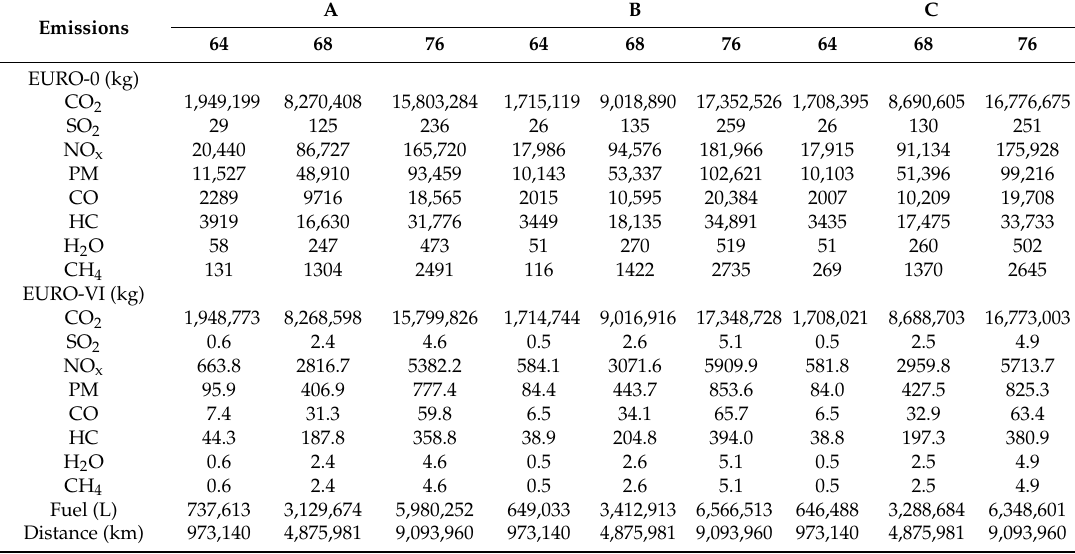
Table 4. Energy efficiency of timber transportation (EURO-0 and EURO-VI engines) for diesel fuel consumption (L) and environmental emissions in respect to the distance travelled in the STS. The vehicle combinations (64, 68 and 76 t) are managed using TFMC A, B and C for driving on forest roads: A = 40, 4 and 2% for 64, 68 and 76 t vehicles, respectively; B = 15, 15 and 15%, respectively; and C = 5, 5 and 5%, respectively. Emissions include carbon dioxide (CO 2 ), sulphur dioxide (SO 2 ), nitrogen oxides (NO x ), particulate matter (PM), carbon monoxide (CO), hydrocarbons (HC), water (H 2 O), methane (CH 4